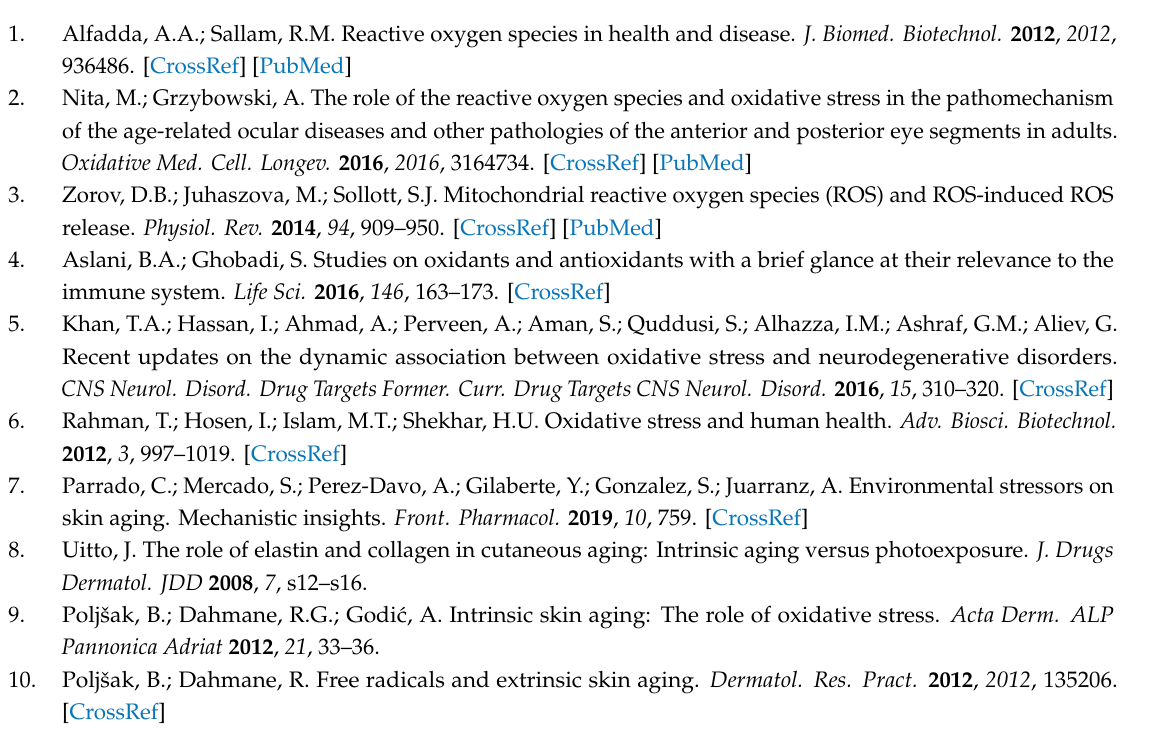
Figure S1: LC / MS analysis of the EtOAc fraction of U. davidiana var. japonica extract (detection wavelength was set at 254 nm) and UV spectra of compounds 1 – 3 ; Figure S2: The 1H NMR spectrum of compound 1 in CD 3 OD and negative ion-mode ESI-MS data of 1; Figure S3: The 1H NMR spectrum of compound 2 in CD 3 OD and negative ion-mode ESI-MS data of 2; Figure S4: The 1H NMR spectrum of compound 3 in CD 3 OD and negative ion-mode ESI-MS data of 3 ; Figure S5: Antioxidant activity of isolated compounds 1 – 3 ; Figure S6: Cell viability of isolated compounds 1 – 3 against normal human fibroblast (NHDF)